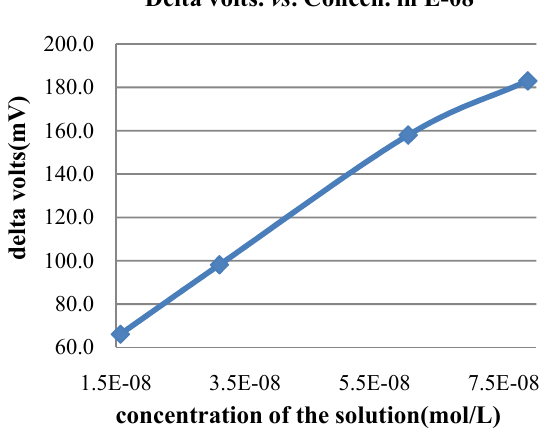
Figure 6. The relationship of the concentrations of the fluorescein solution samples and the voltage differences in 10 ×10 − 8 scale.